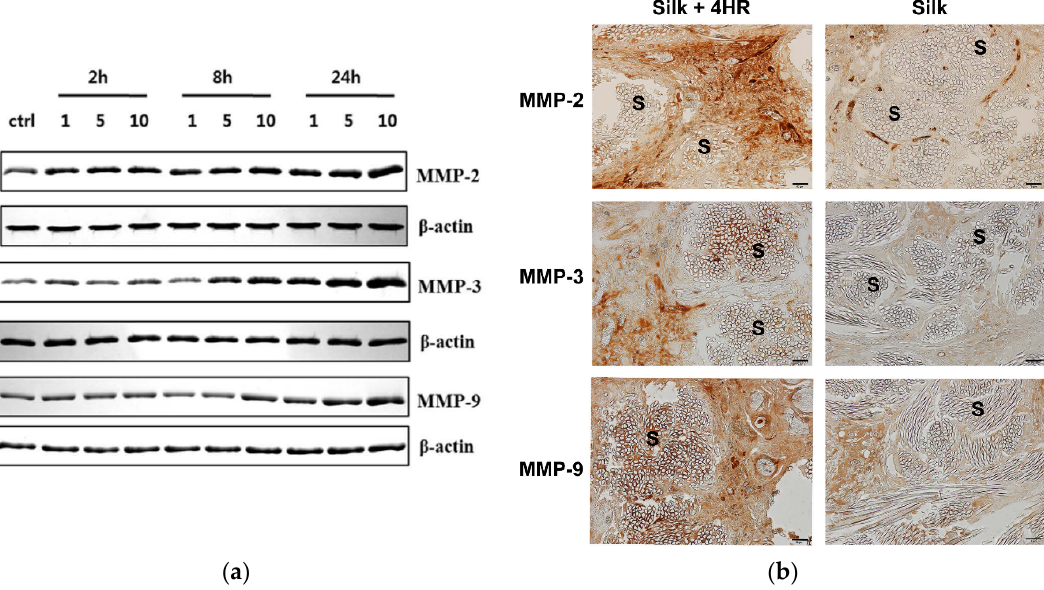
Figure 1. ( a ) 4-hexylresorcinol (4-HR) increases the expression of matrix metalloproteinase (MMP)-2, 3, and 9 in RAW264.7. ( b ) Immunohistochemistry shows the high expression of MMP-2, 3, and 9 in the 4- HR-incorporated silk group compared with the silk-only group in vivo . Reproduced with permission from Kim, S. G.